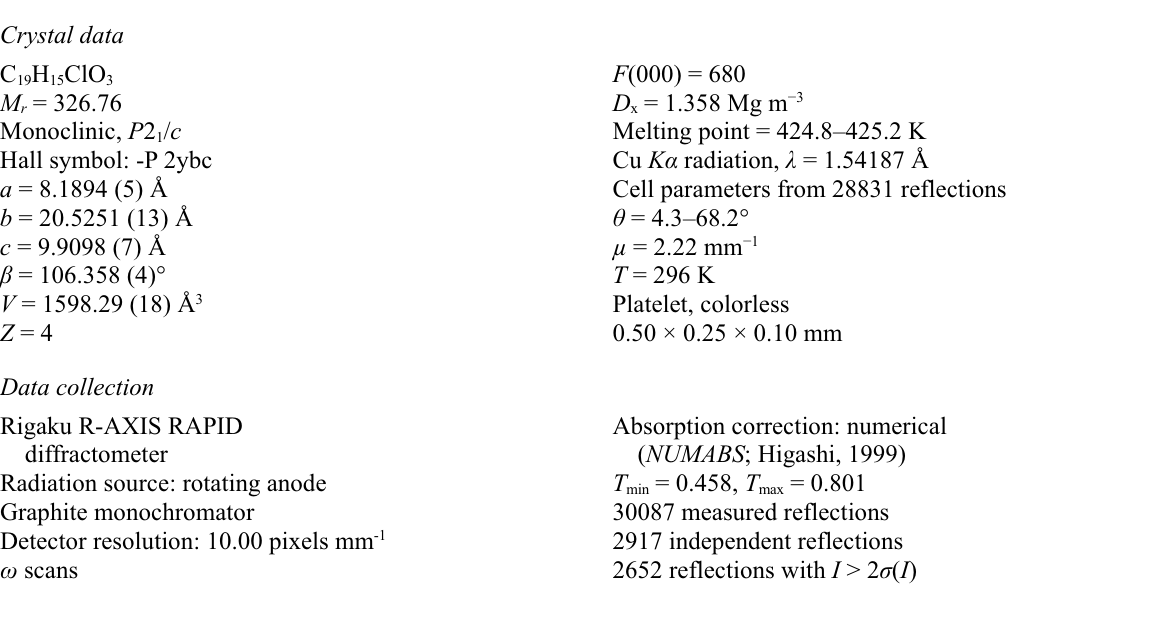
Figure 2 A partial packing diagram of the title compound, viewed down the c axis. The dashed lines indicate hydrogen bonds.